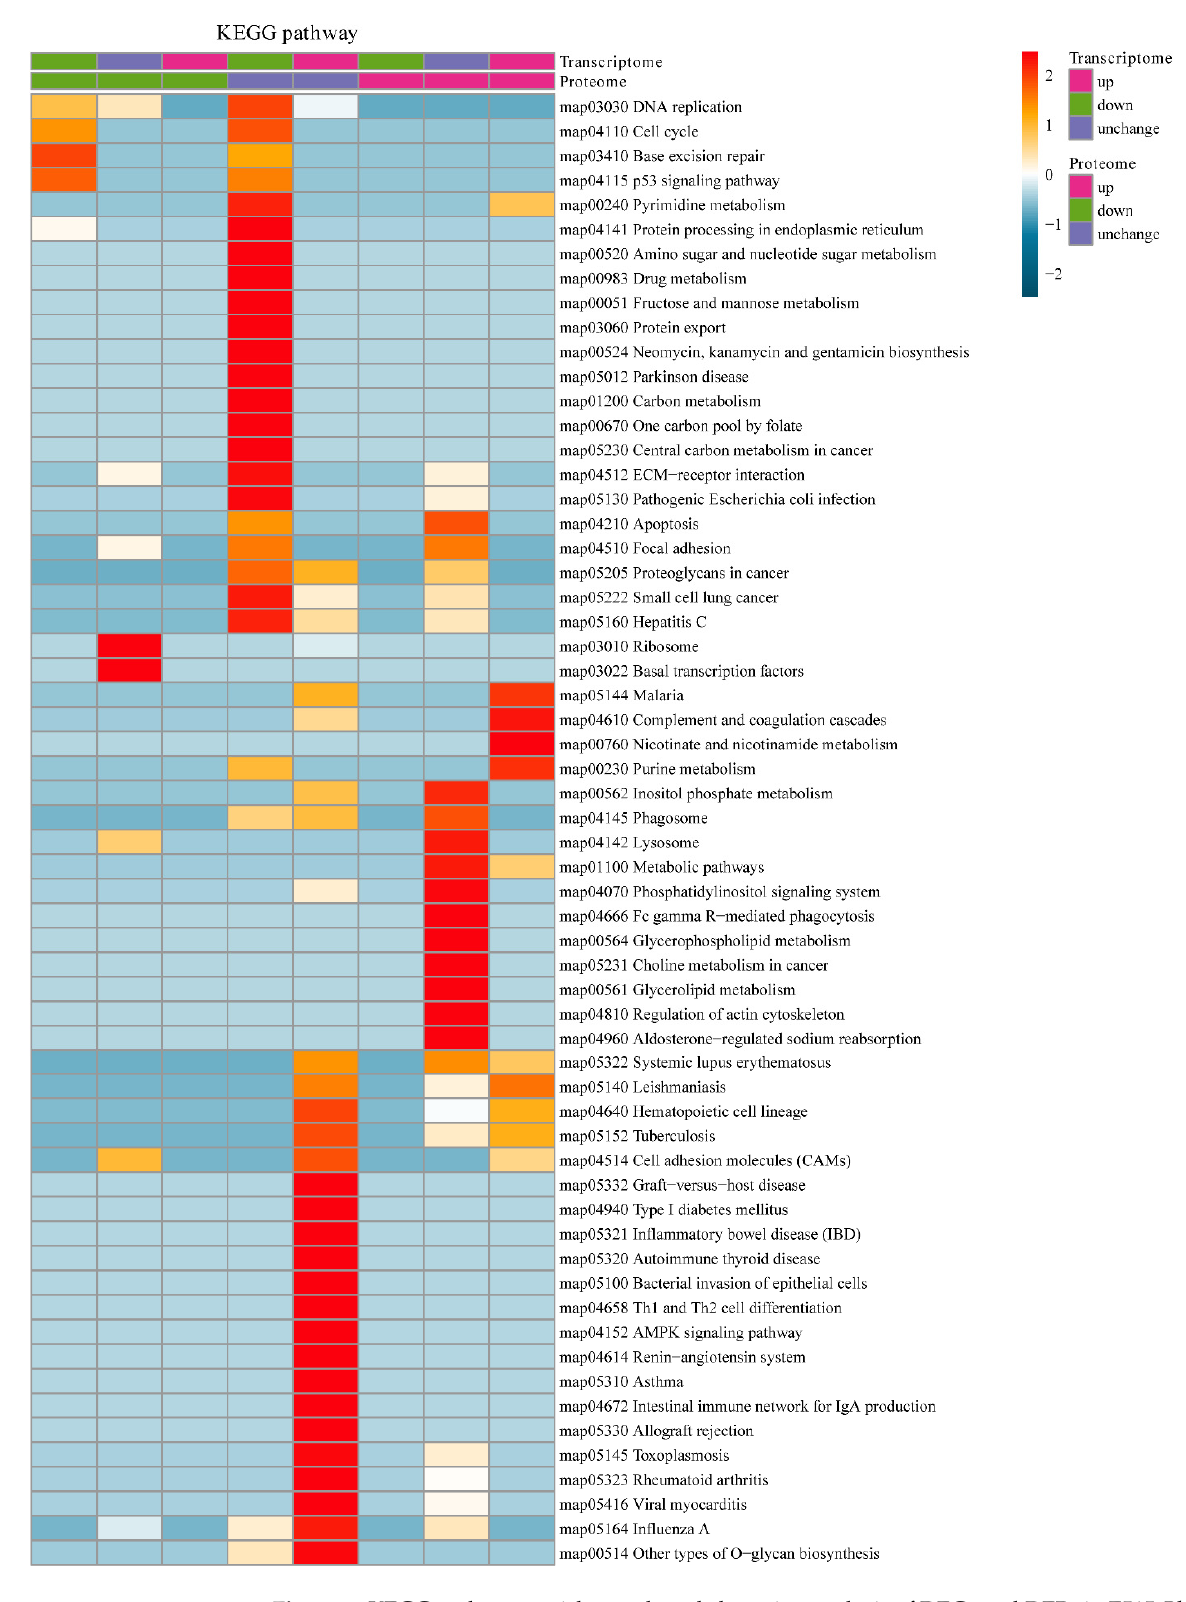
Figure 8. KEGG pathway enrichment-based clustering analysis of DEGs and DEPs in E515- Bb vs. Bb .